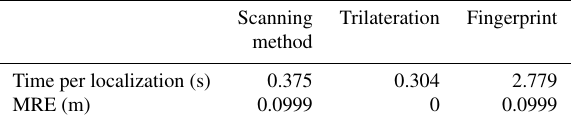
Figure 3. Path reconstruction using the scanning method and fin- gerprint (a) and trilateration (b) for noisy simulation data. Table 1. Comparison of reviewed localization methods in terms of time and mean reconstruction error for noise-free